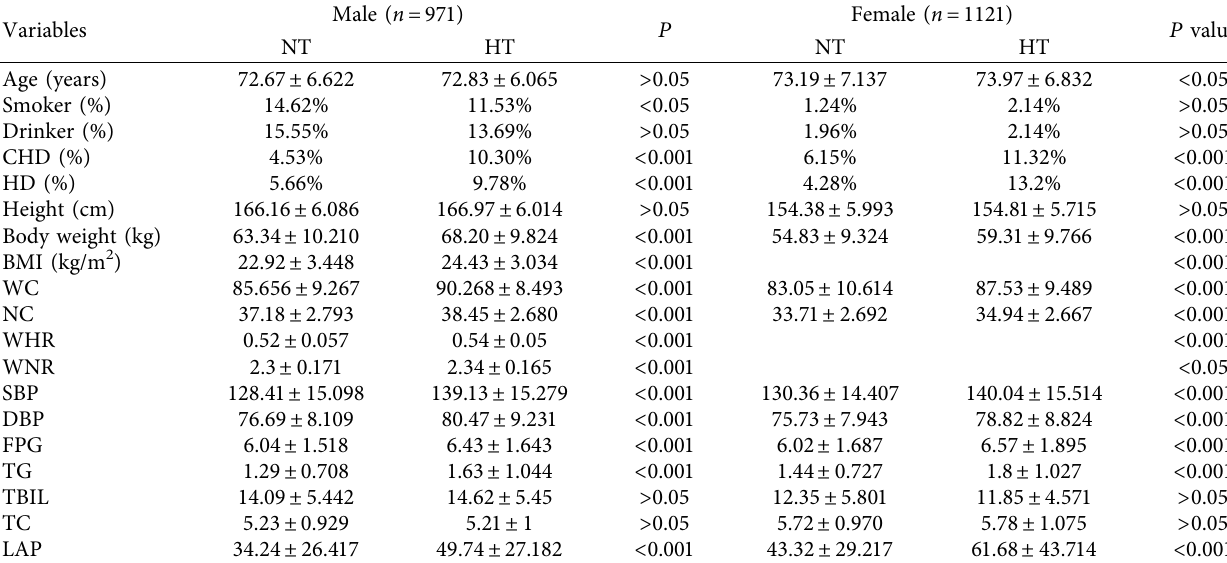
Table 2: Baseline characteristics of males and